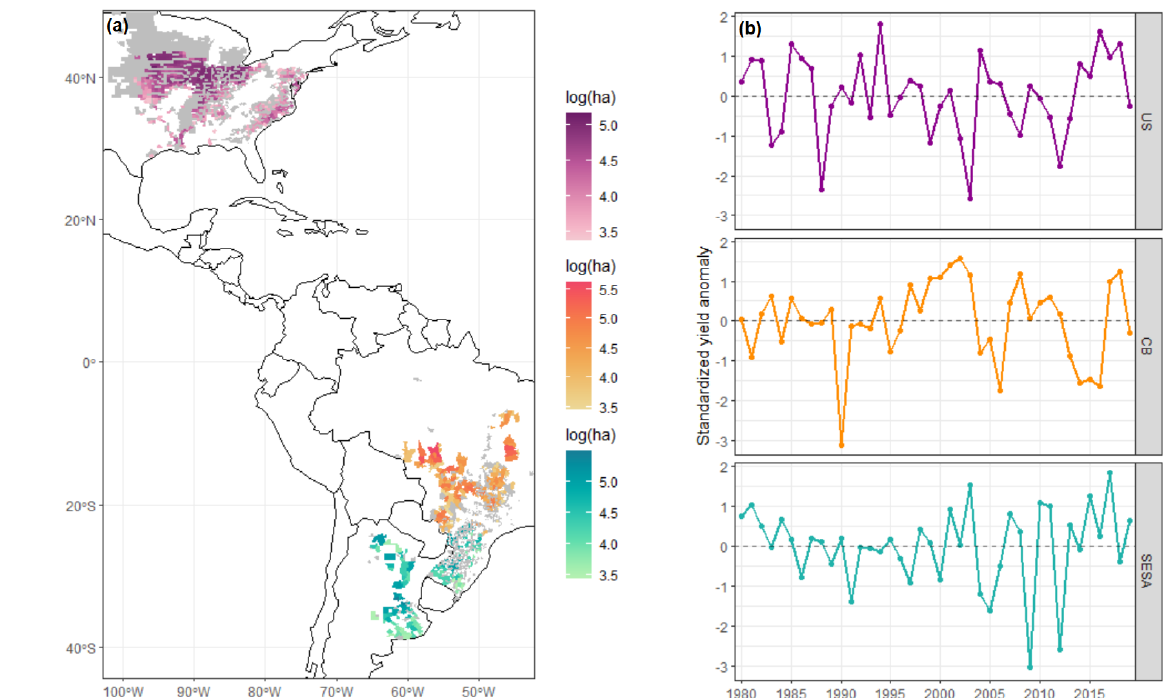
Figure 1. (a) Soybean harvested area in hectares (ha) per county (logarithmic scale) in North and South American breadbaskets considered for this analysis. Colors represent three separate cluster regions: US (purple), central Brazil (orange) and southeast South America (green). Gray represents regions that have been masked out due to data availability and land management. (b) Harvest area weighted-average yield time series for the three considered target